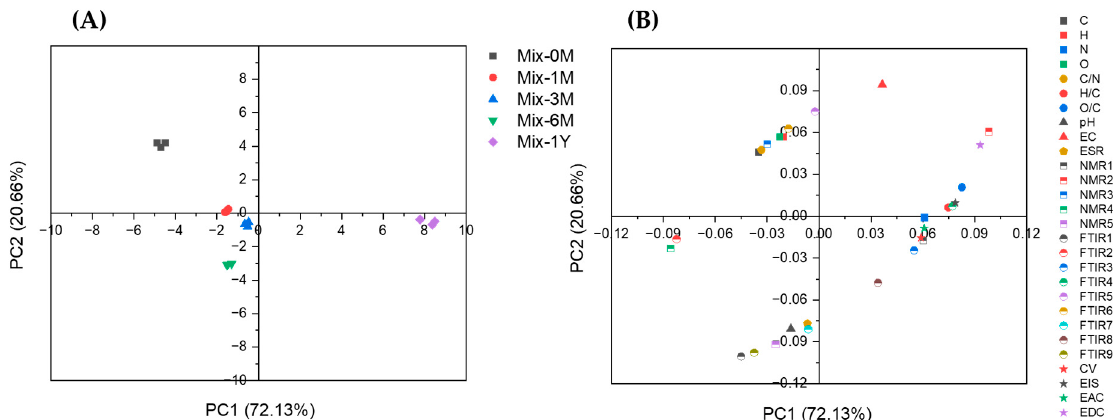
Figure 8. Principle component analysis of rice straw-artificial soil mixtures (Mix) with different humification periods ( A ) and loadings of various chemical and electrochemical parameters ( B ). C, H, N, and O denote carbon, hydrogen, nitrogen, and oxygen percentage of Mix sample, respectively (assuming no change in ash content); C/N, H/C, and O/C denote carbon to nitrogen, hydrogen to carbon ratio, and oxygen to carbon ratio of Mix sample, respectively (elemental ratio); pH denotes pH value of Mix sample; EC denotes electrical conductivity of Mix sample; ESR denotes signal intensity of Mix sample in ESR analysis; NMR1, 2, 3, 4, and 5 denote quantitative carbon content of alkyl carbon (0–45 ppm), N-alkyl carbon (45–60 ppm), carbohydrate carbon (60–110 ppm), aromatic carbon (110–160 ppm), and carbonyl carbon (160–210 ppm), respectively (Figure 3C); FTIR1, 2, 3, 4, 5, 6, 7, 8, and 9 denote relative intensity of O-H (3674 cm − 1 ), O-H and N-H (3431 cm − 1 ), C-H (2927 cm − 1 ), C-H (2854 cm − 1 ), O-H of kaolin and C=O of lignin/hemicellulose (1643 cm − 1 ), aromatic skeleton of lignin (1511 cm − 1 ), Si-O in artificial soil (950 cm − 1 ), Al-OH of artificial soil (798 cm − 1 ), and Si-O in artificial soil (696 cm − 1 ) in the FT ‐ IR spectra, respectively (with C ‐ O/Si ‐ O (1078 cm − 1 ) as the base); CV denotes Q CV /gC (Calculation S3); EIS denotes CPE2 ‐ Q 0 /gC (Figure 6); EAC denotes electron accepting capacity of Mix sample; EDC denotes electron donating capacity of Mix sample (Figure 7A).